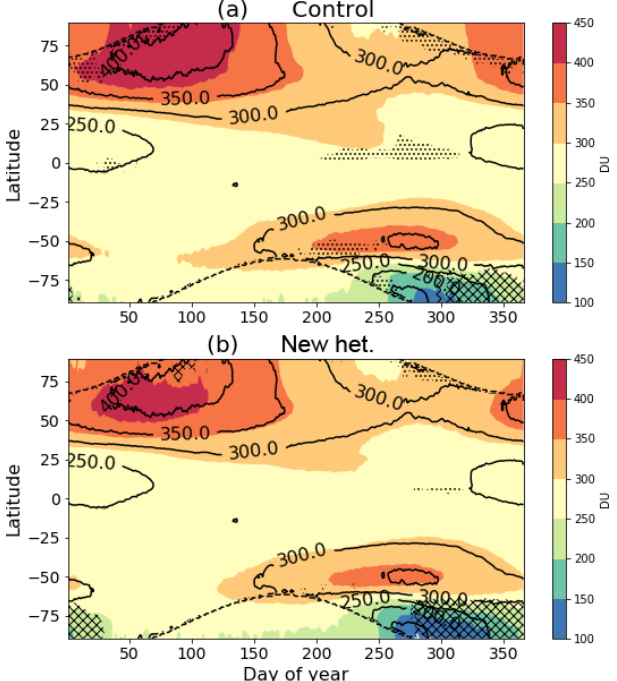
Figure 5. Zonal mean total column ozone climatology (1996–2009, excluding 2002) of the (a) control and (b) “new het.” runs. Con- tours show the NIWA-BS data; crosshatching/stippling indicates where the model under-/overestimates NIWA-BS data by more than 30DU. Dashed contours mark the absence of NIWA-BS data.